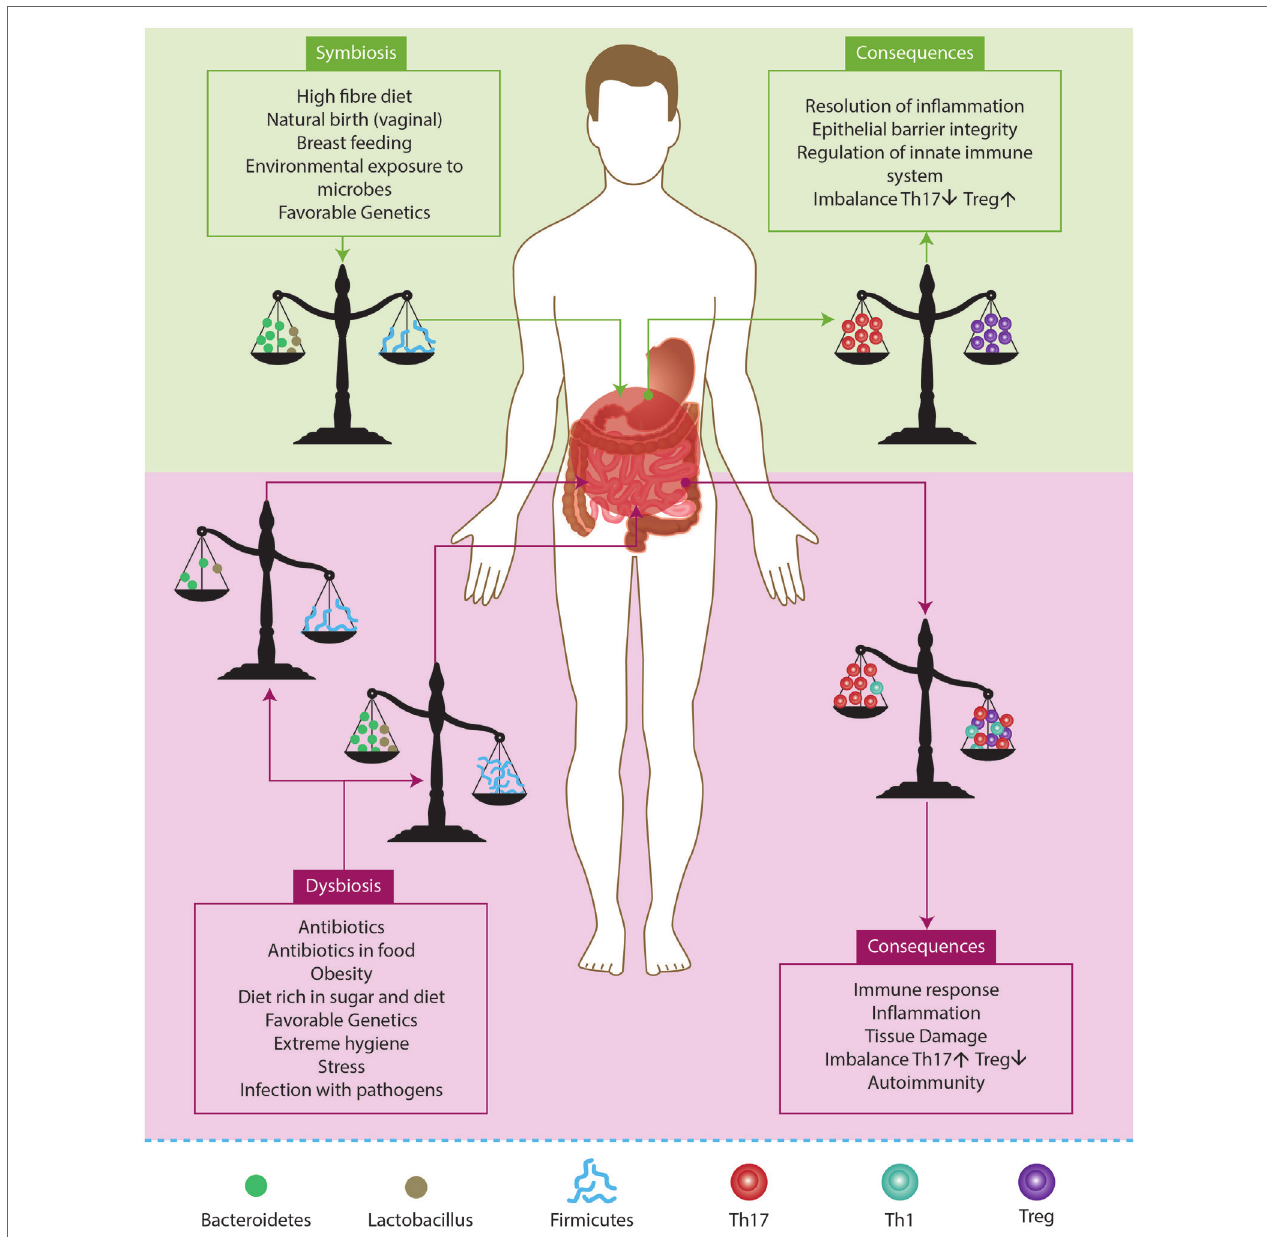
FiGURe 7 | Factors influencing gut microbiota . A balancing microbiota in symbiosis influences the equilibrium between T regulatory cells (Treg) and effector T cells (Th1, Th17). As a consequence, the gut can respond to an infection but this also leads to the permanence of microbiota and favors the host. By contrast, if the environment induces the rupture of the equilibrium, it induces a state of dysbiosis. Hence, the percentage of anti- inflammtory microorganisms (e.g., Bacteroidetes and Lactobacillus ) may be lower than proinflammatory microorganisms (e.g., Firmicutes ). Eventually, this may lead to an inflammatory profile that favors the development of autoimmunity. Adapted from Ref. (129,